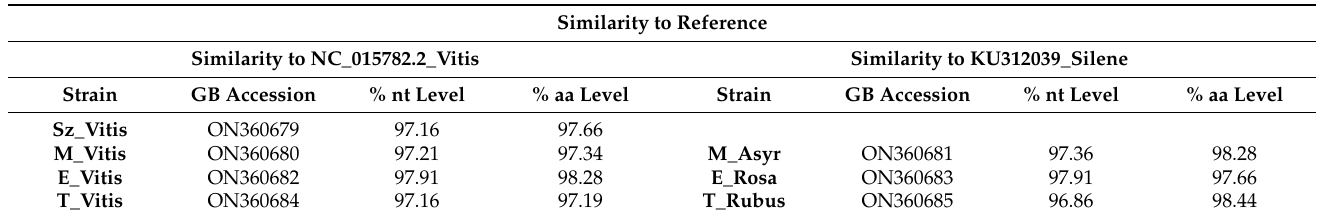
Table 2. Similarity of sequenced 5 (cid:48) parts of GPGV strains to reference genome. Sequences from grapevine were compared to grapevine-originated reference, while sequences from weeds were compared to full GPGV genome originated from Silene.